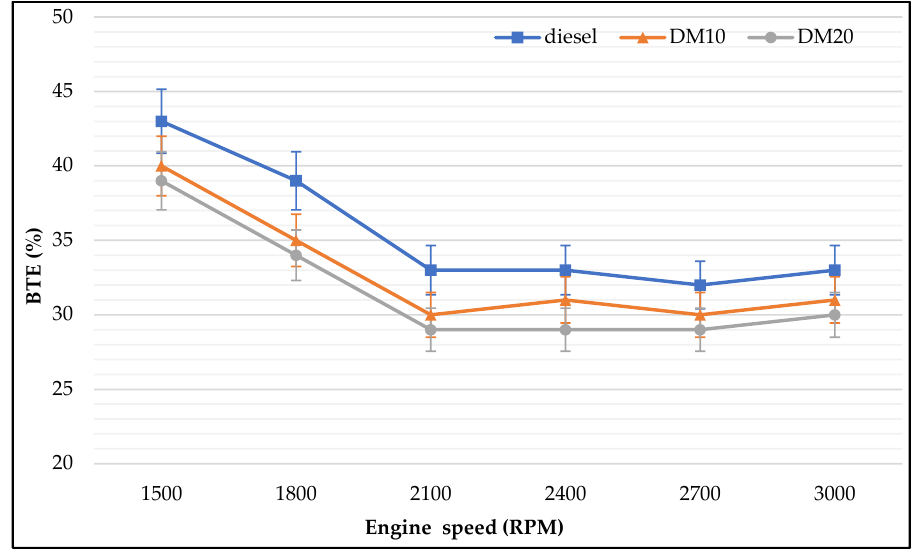
Figure 10. Brake thermal efficiency at different engine speeds.